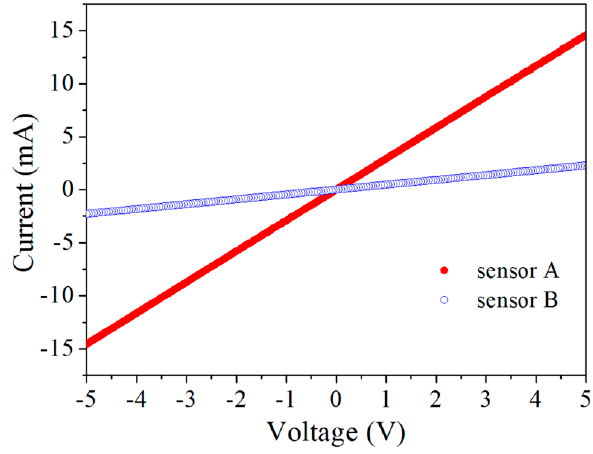
Figure 9. Current–voltage characteristics of the piezoresistors.